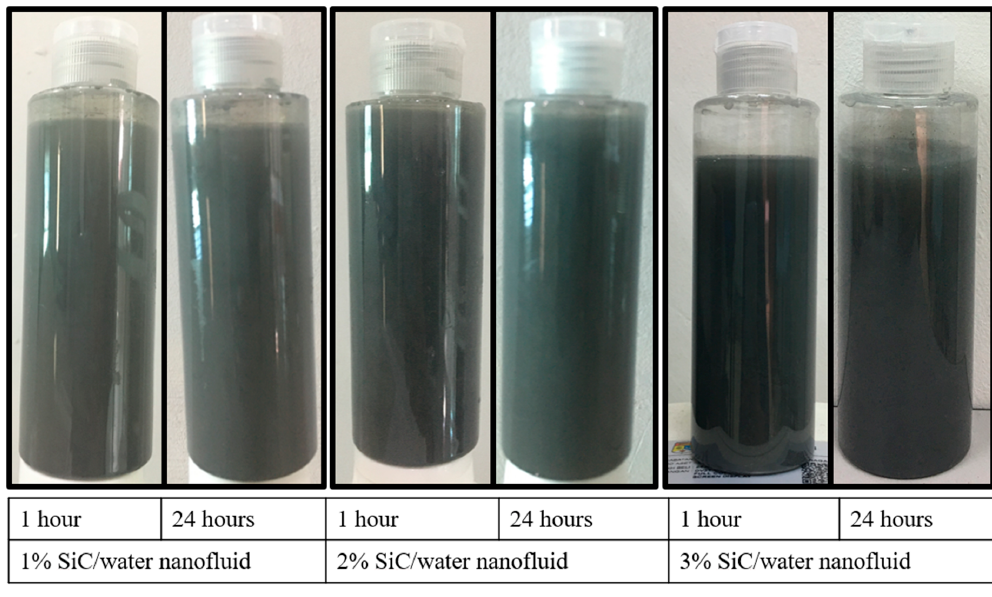
Figure 4. SiC / Water nanofluid at di ff erent ϕ .